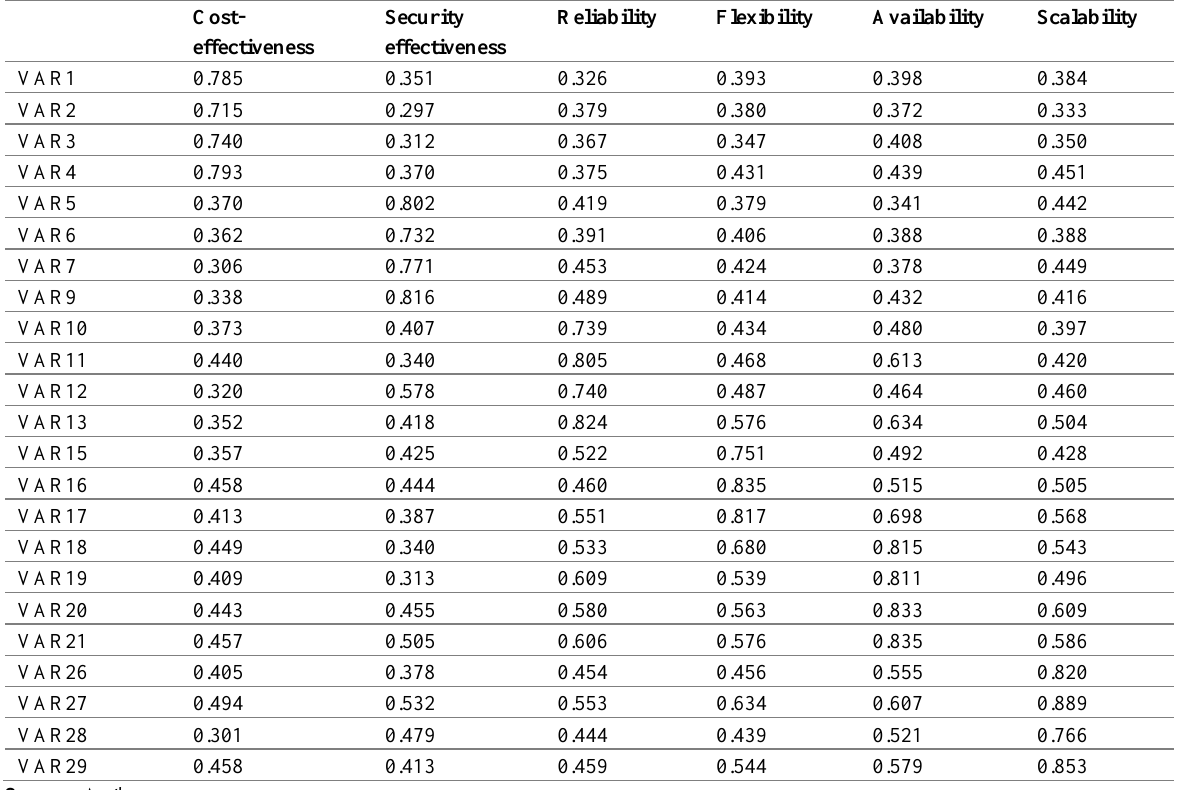
Table 5: Discriminant Validity with Cross-loading